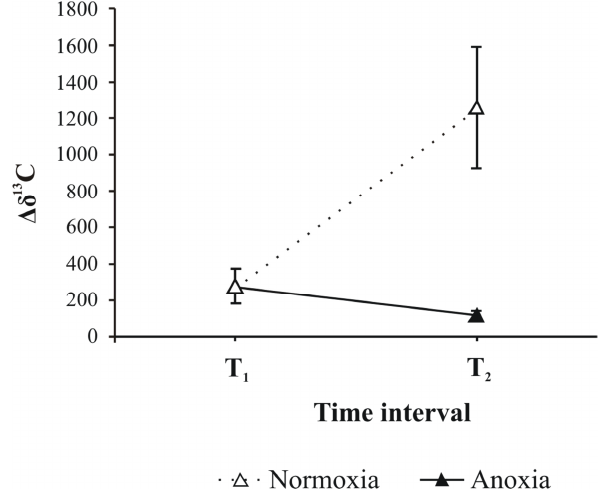
Fig. 7. Average ( ± STDEV) diatom uptake by harpacticoid cope- Figure 7. Average (± STDEV) diatom uptake by harpacticoid copepods under normoxic and 2 pods under normoxic and anoxic conditions at two time intervals anoxic conditions at two time intervals (T 3 ( T 1 , T 2 ) expressed as specific uptake ( 1δ 13 C). T 2 represents 6 or 7 additional days in normoxic or anoxic conditions, represents 6 or 7 additional days in normoxic or anoxic conditions, respectively. 4